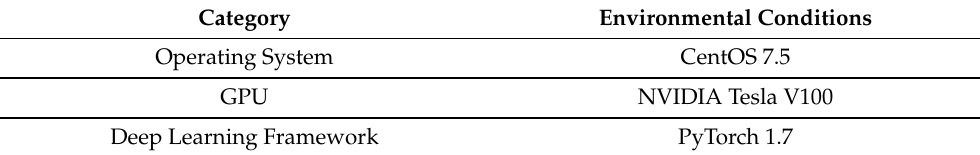
Table 1. Experimental